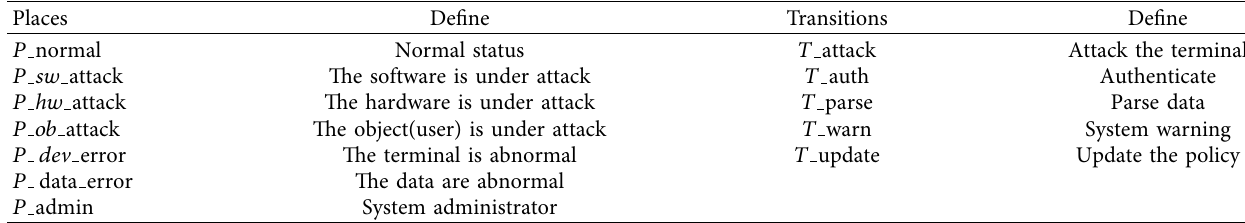
Table 1: Defnition of places and transitions.